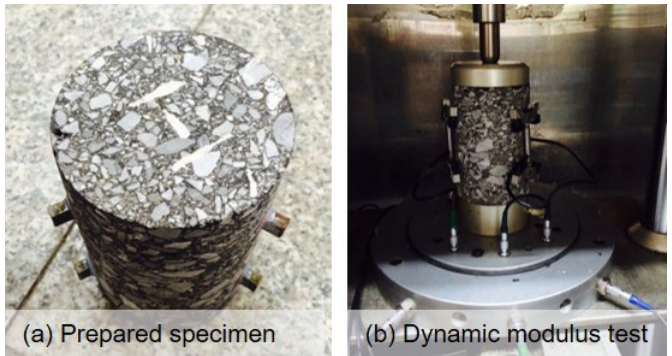
Figure 3. The testing of the dynamic modulus of the recycled asphalt mixture.